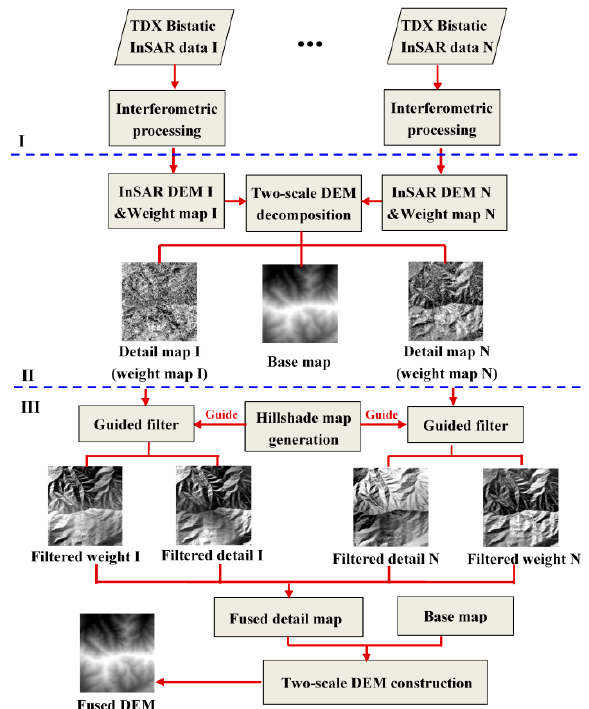
Figure 1. Flowchart for the interferometric synthetic aperture radar digital elevation model (InSAR DEM) fusion with guided filter method.